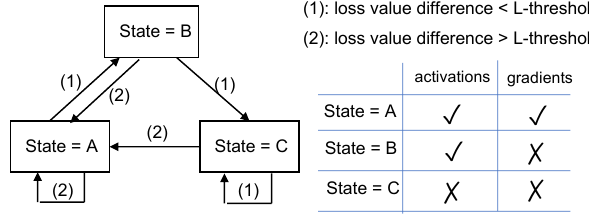
Figure 4. State diagram for controlling client-server communications in